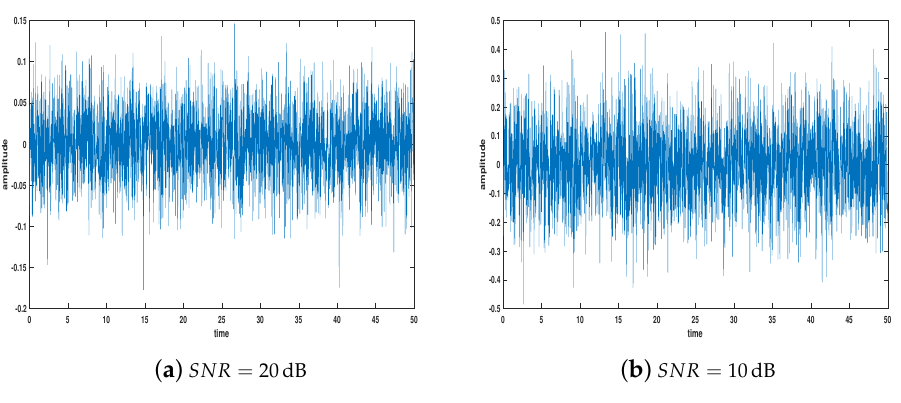
Figure 3. The output error of example